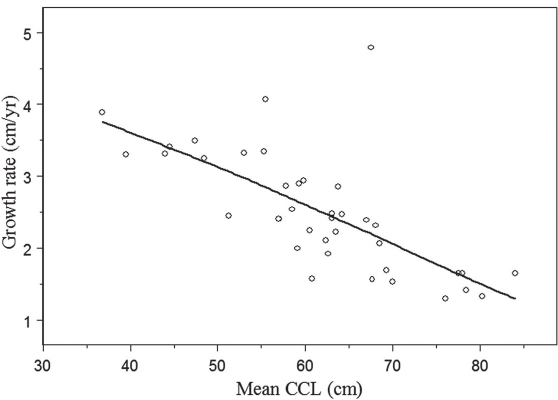
Fig . 2. – estimated size-specific growth rate function for the Medi- terranean loggerhead sea turtles produced by the gaM model fit. open circles represent fitted values for the gaM model, solid curve represent the cubic-b smoothing spine fitted to those values. CCl: Curved Carapace length.